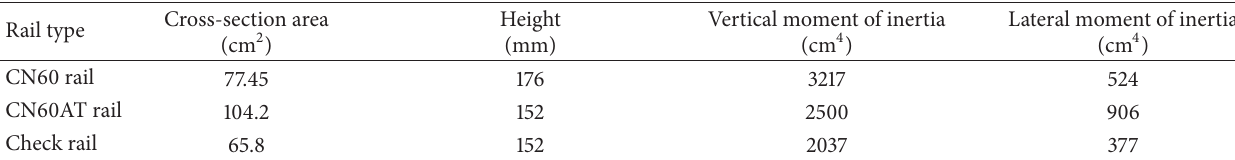
Table 1: Cross-section parameters of high-speed turnout rails.